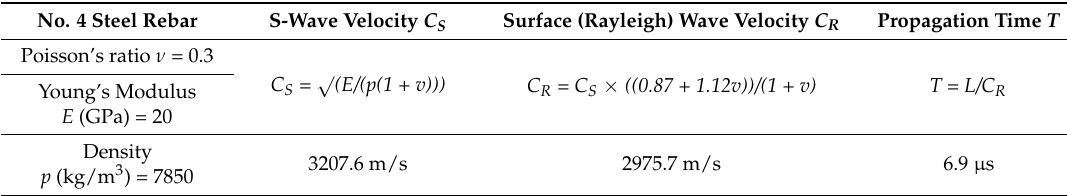
Table 1. Propagation speed of ultrasound waves in No. 4 steel rebar.